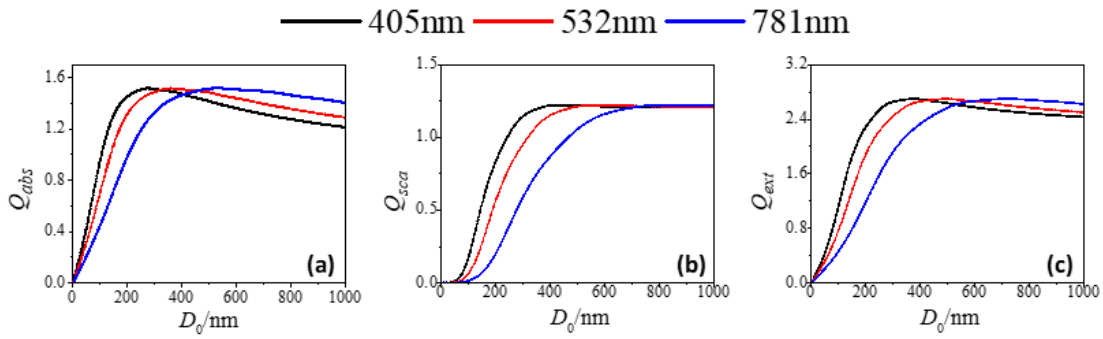
Figure 2. ( a ) Changes in absorption e ffi ciency ( Q abs ), ( b ) scattering e ffi ciency ( Q sca ) and ( c ) extinction e ffi ciency ( Q ext ) with soot particle core size D 0 at λ = 405, 532 and 781 nm (without coating